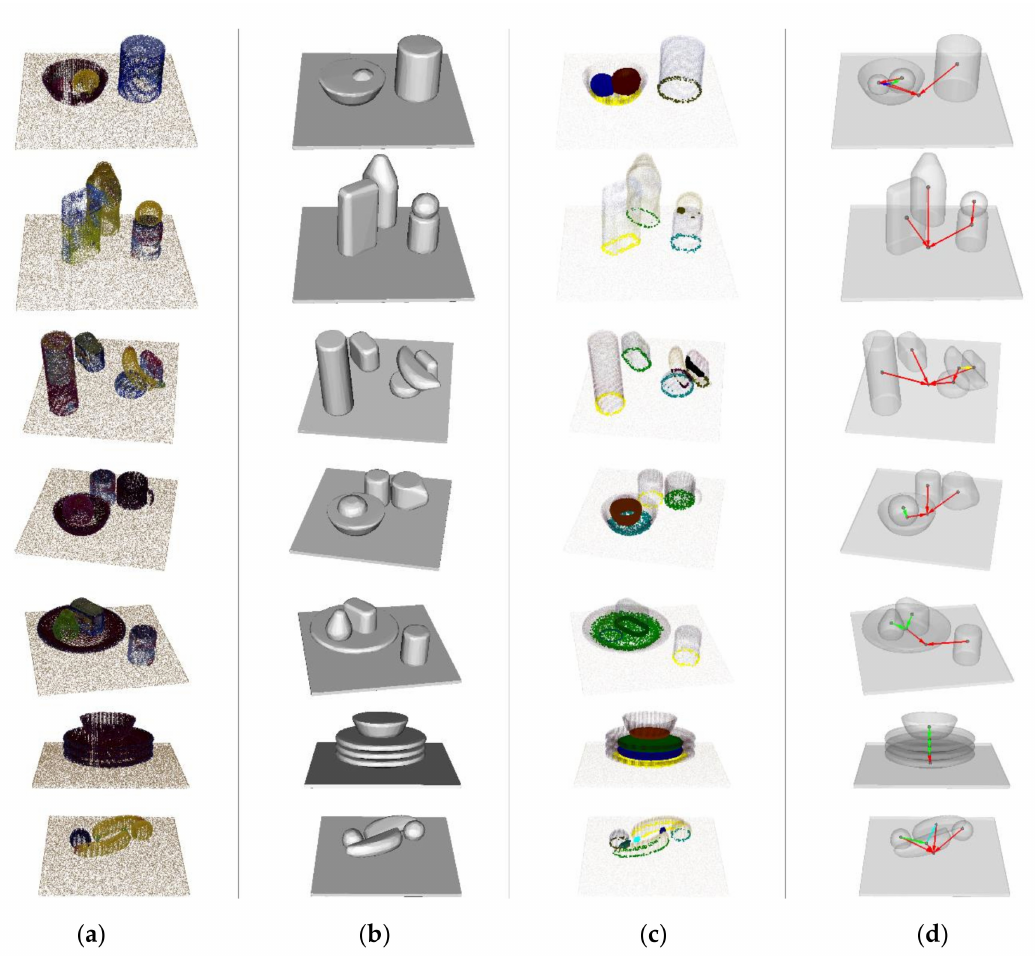
Figure 6. Visualized results of our spatial topological relation analysis on the YCB benchmarks: ( a ) The original images of cluttered scenes 8 to 14; ( b ) 3D models of convex hull; ( c ) Boundary points and interior points; ( d ) Spatial topological relations between